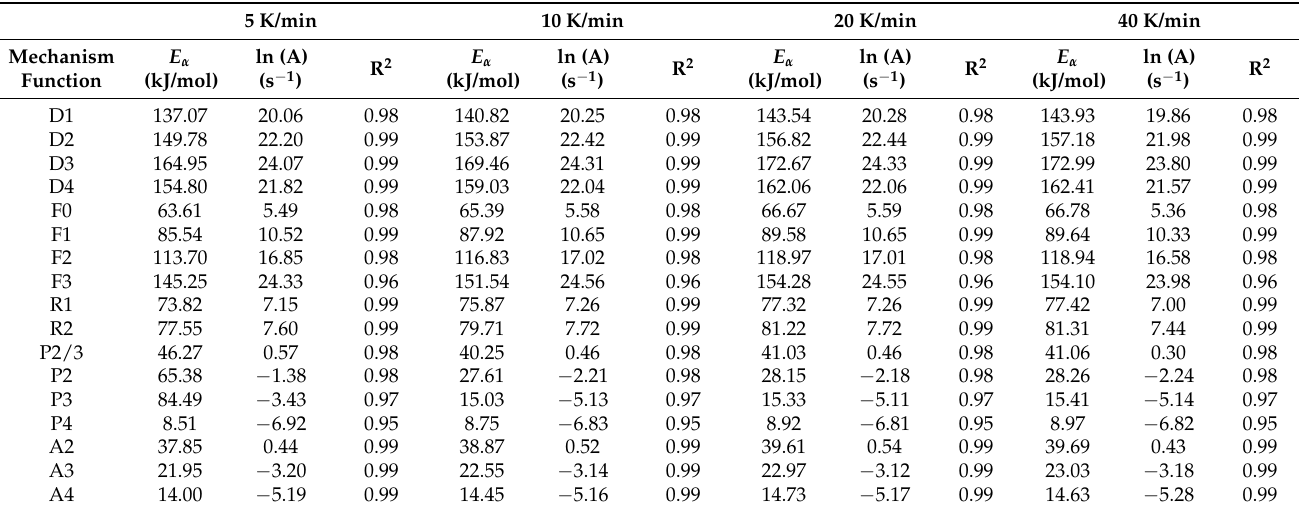
Table 4. Activation Energy and ln A of Natural Aging—10 Chinese Fir under Different Mechanism Functions.